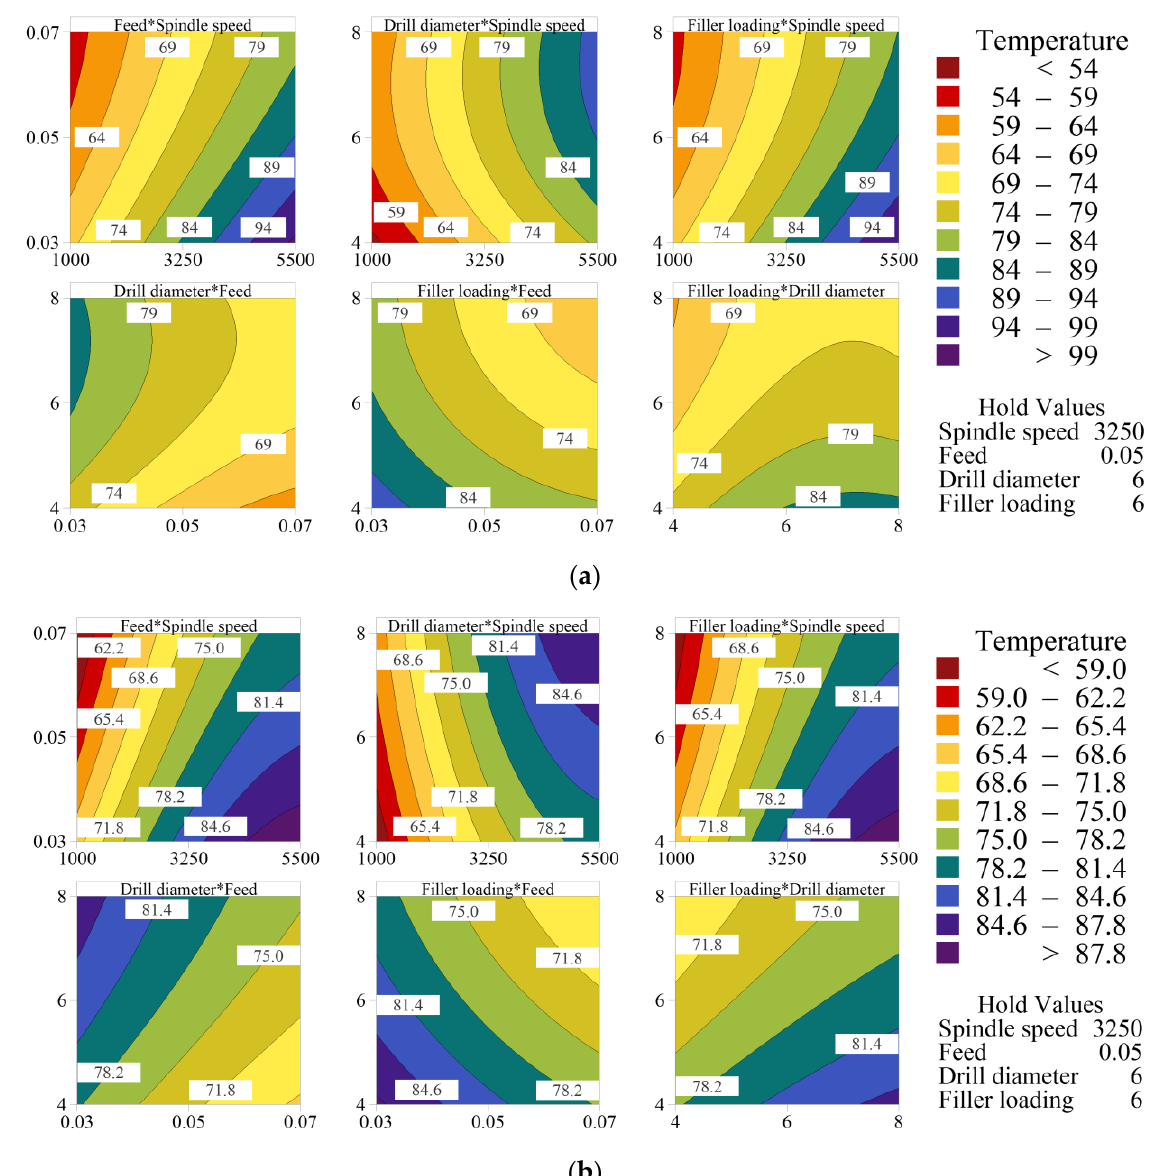
Figure 16. Temperature contour plot of ( a ) MoS 2 -loaded CEC and ( b ) h-BN-loaded CEC. Figure 15. Temperature contour plot of ( a ) MoS 2 -loaded CEC and ( b ) h-BN-loaded